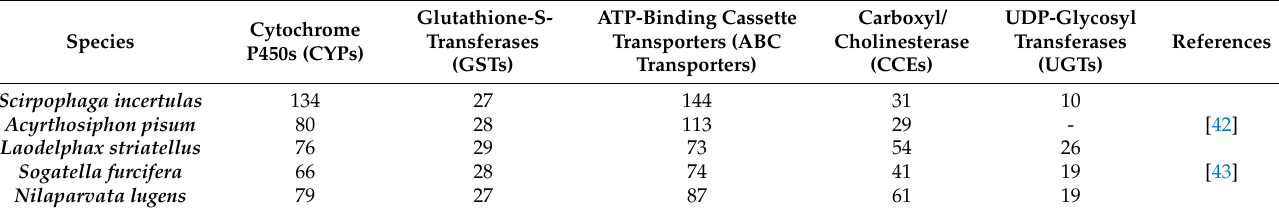
Table 3. Comparative analysis of detoxifying